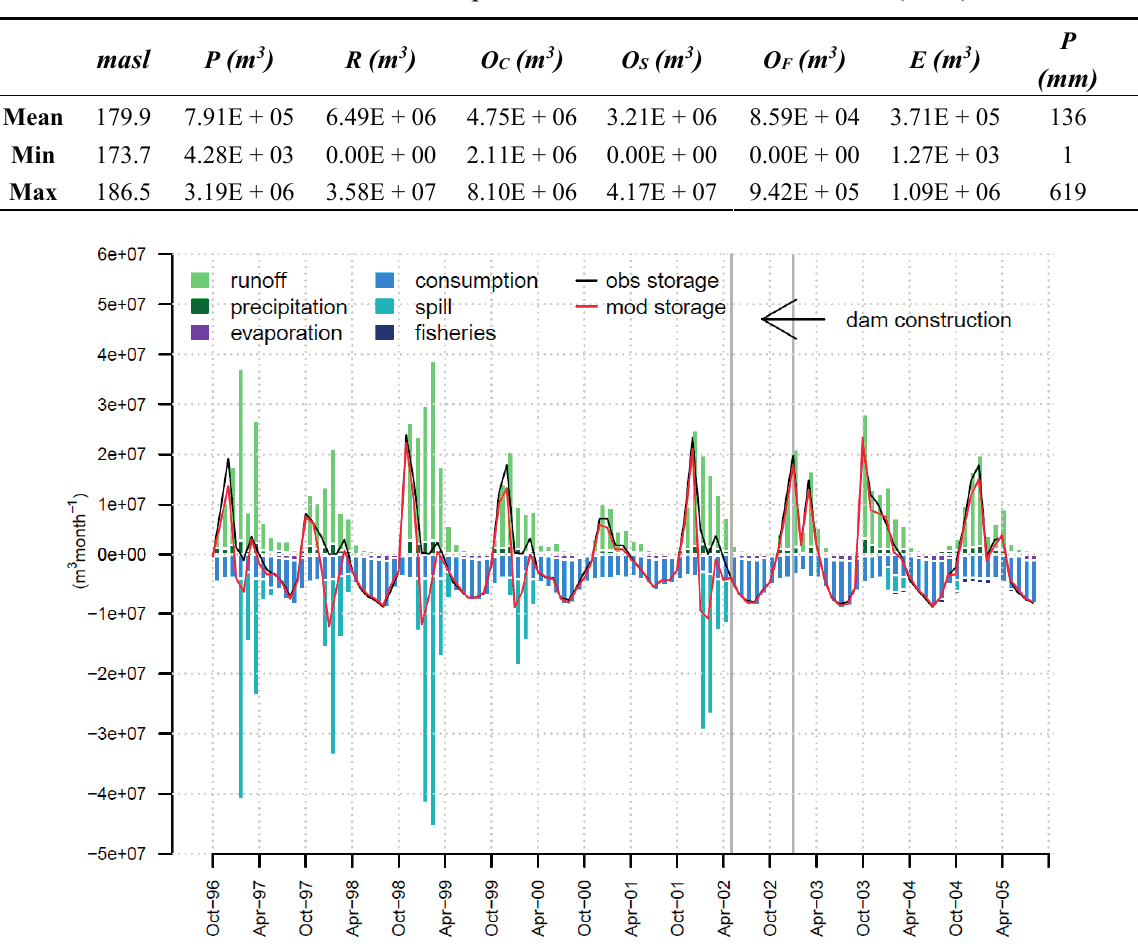
Figure 3. Monthly precipitation (dark green), inflows (light green), evaporation (purple), consumption (light blue), spill (turquoise) and fisheries release (dark blue) for the SR from 1996 to 2005are shown as a bar chart. Monthly observed storage (black) and simulated storage (red) are shown as